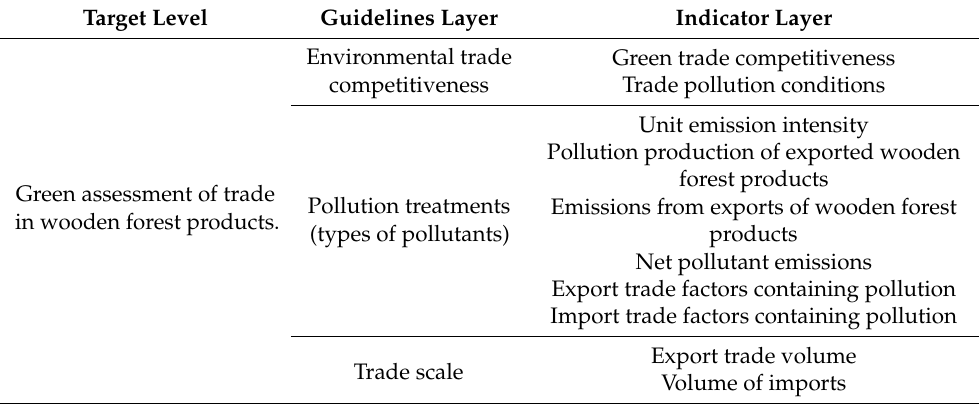
Table 1. Green evaluation system of trade in wooden forest